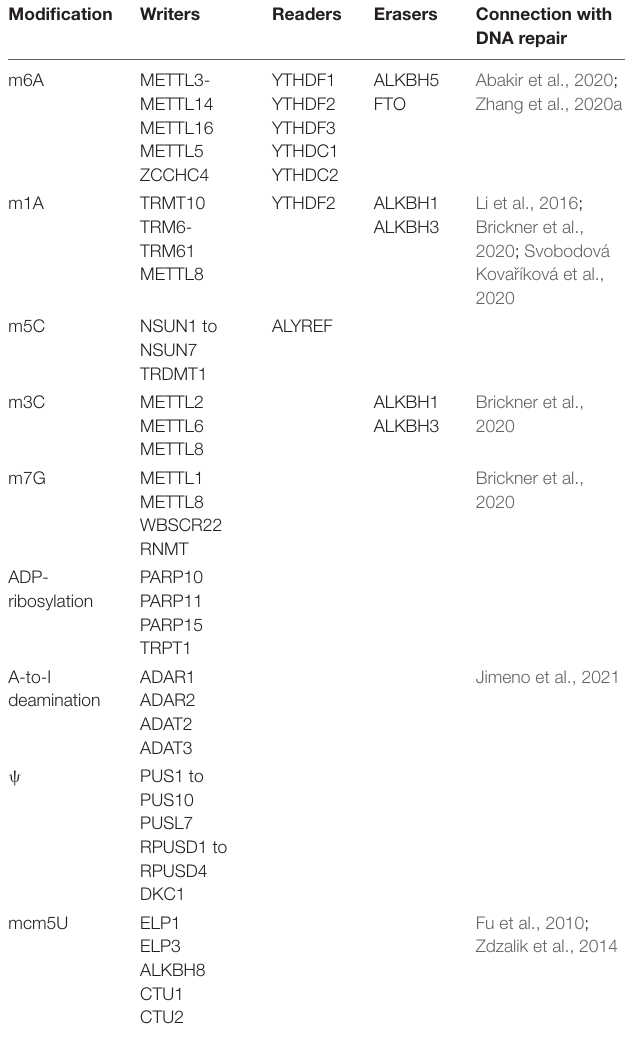
TABLE 1 | Principal RNA modifications and their connection with DNA